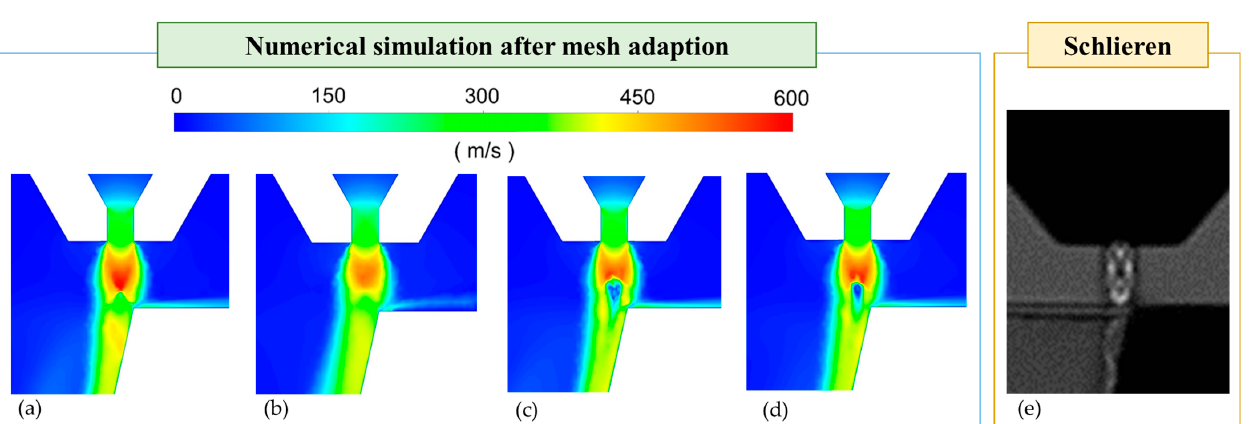
Figure 11. Density gradient from CFD simulation and Schlieren image. ( a ) k– ε (realizable) turbulence model, ( b ) k– ε (standard) turbulence model, ( c ) k– ε (RNG) turbulence model, ( d ) k– ω turbulence model, and ( e ) Schlieren experiment result.